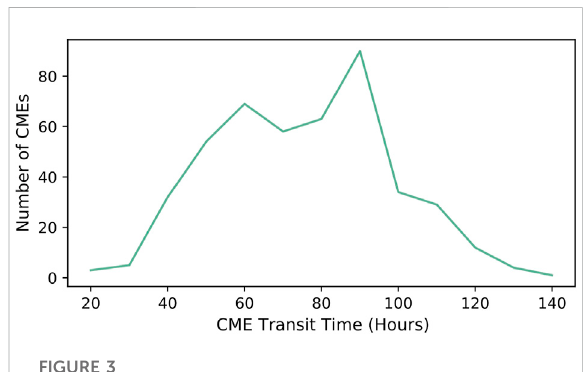
FIGURE 3 DistributionofthetransittimesoftheCMEsconsideredinthis study. For the CMEs, the smallest transit time is 18 h while the largest transit time is 138